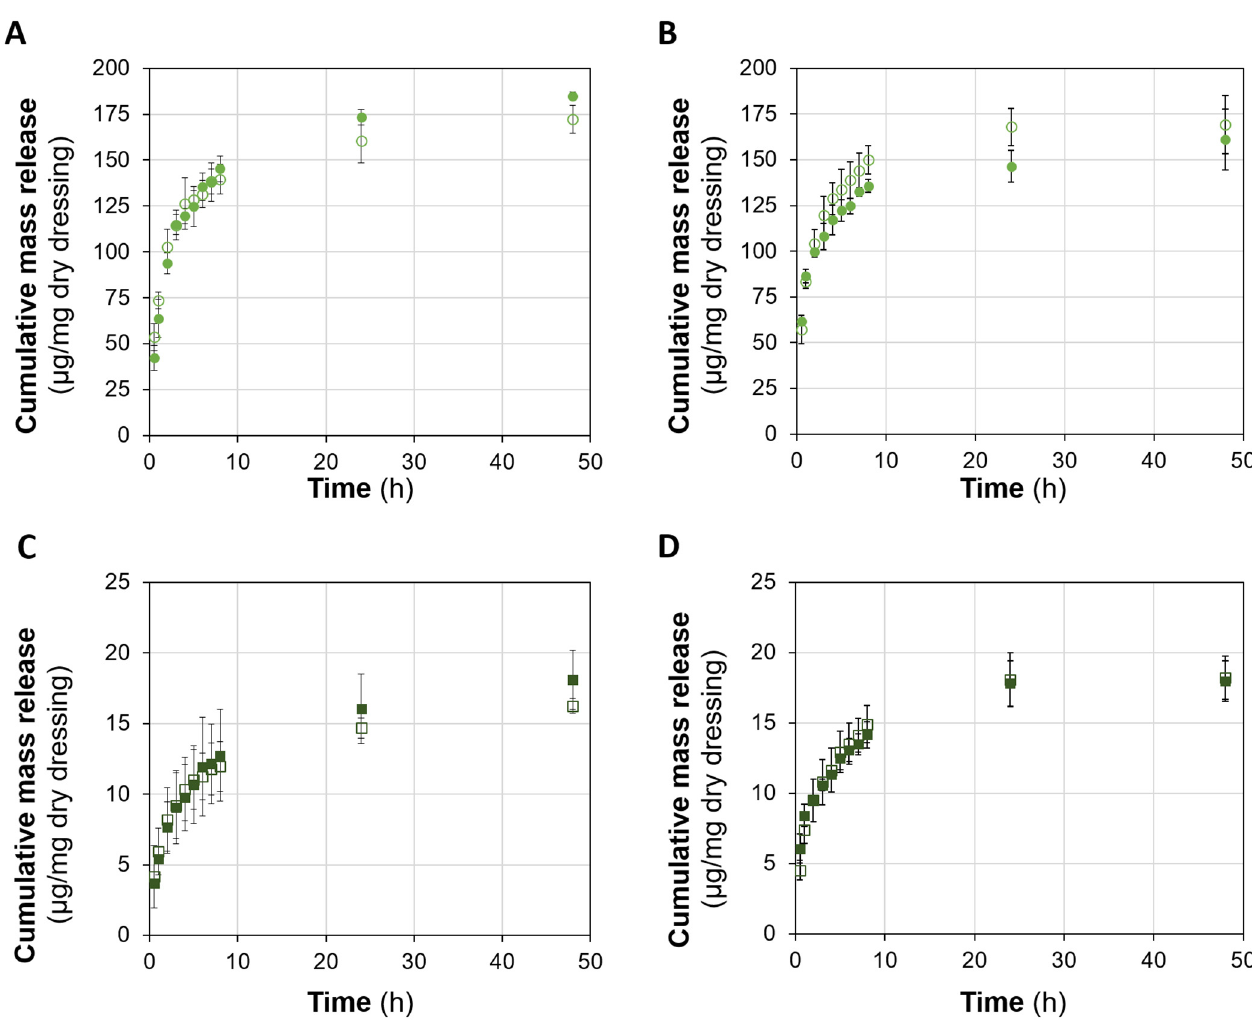
Figure 6. Cumulative drug release profiles from sterile (solid symbols) and non-sterile (open sym- bols) CS ( A , C , E ) and C ( B , D , F ) hydrogels: 2-Phenoxyethanol ( A , B ), octenidine dihydrochloride ( C , D ), and polyhexanide ( E , F ). Error bars correspond to ± standard deviations (n = 3).